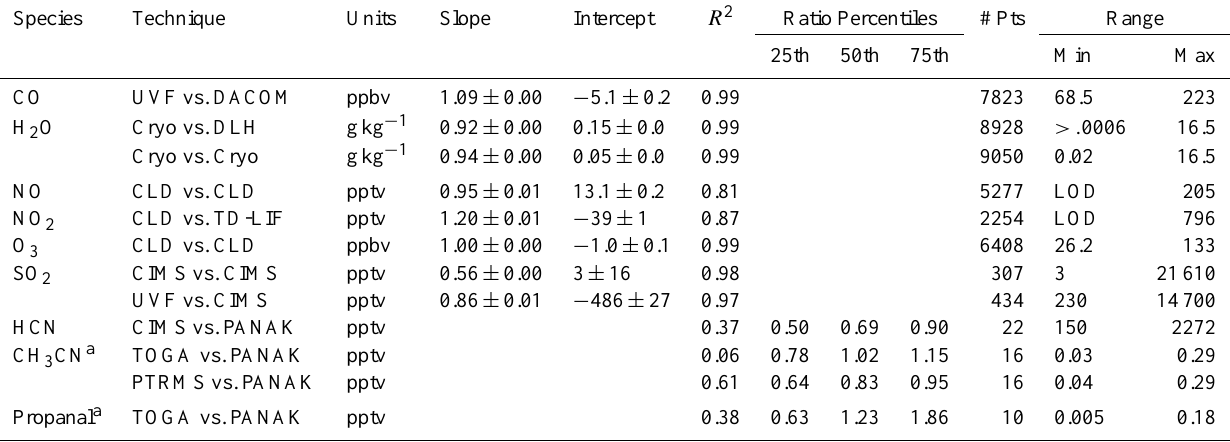
Table 3a. Statistical results of DC-8/C-130 intercomparison. Photochemical precursors and gas phase tracers. NOTE: Technique is listed as X (C-130) vs. Y (DC-8).